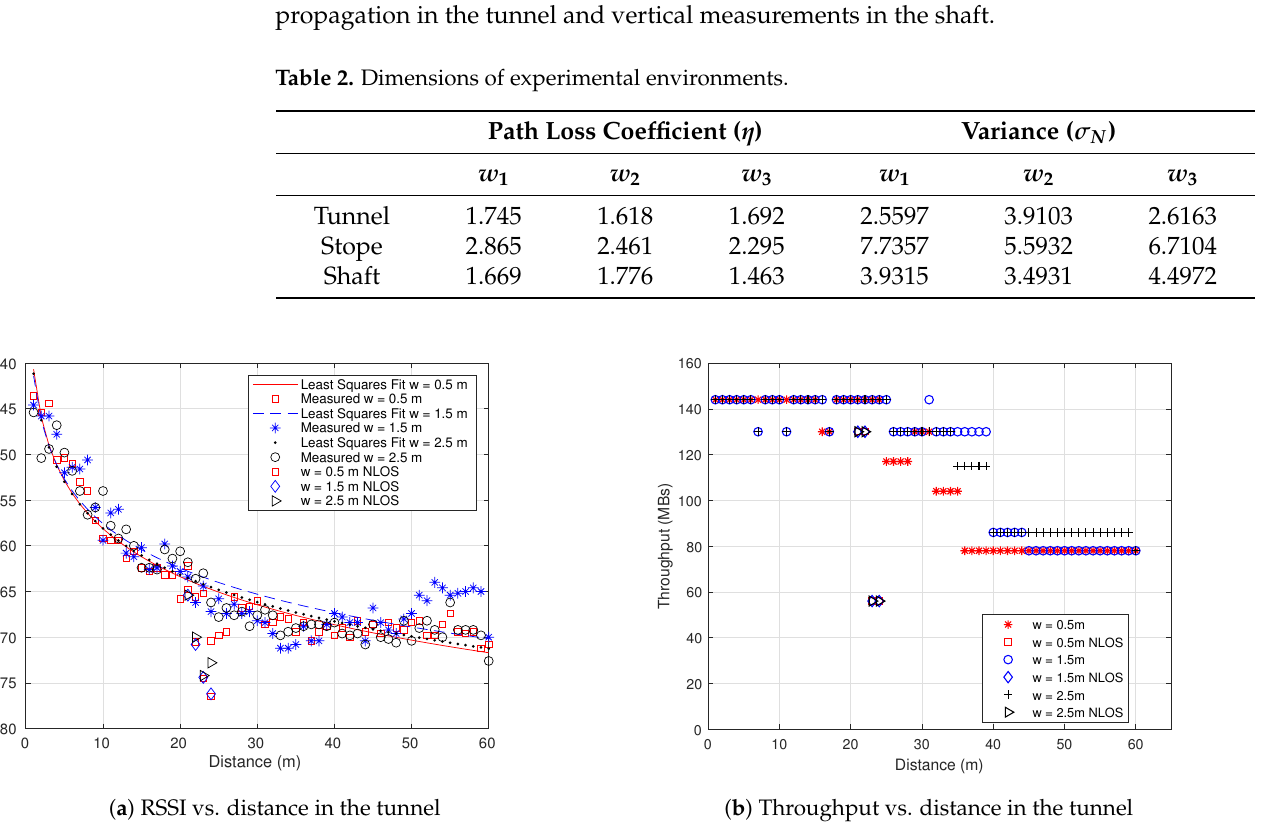
Figure 6. RSSI and throughput obtained at distance points in the tunnel.